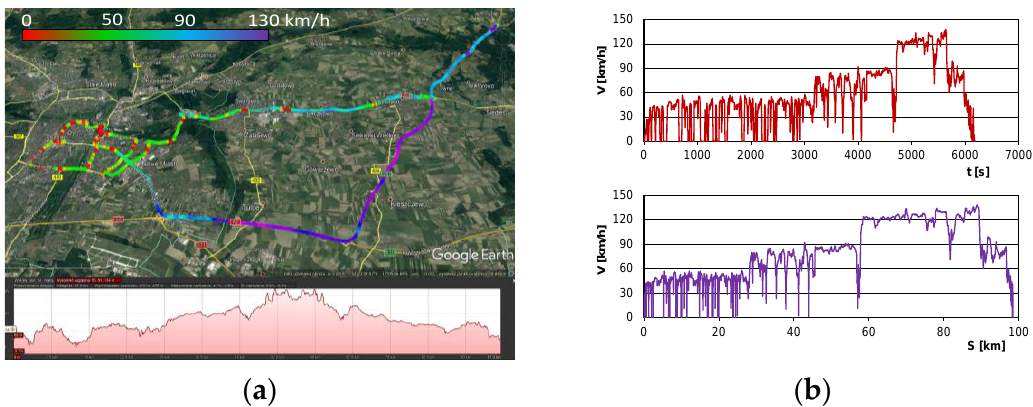
Figure 3. Example visualization of the test route with the description of the relative elevation ( a ) and the relation of speed, time, and covered distance ( b ).